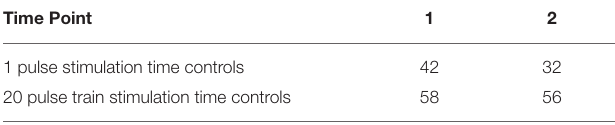
TABLE 3 | Number of neurons responding to electrical stimulation in control conditions and in the presence of antagonists. Time Point 1 2 1 pulse stimulation time